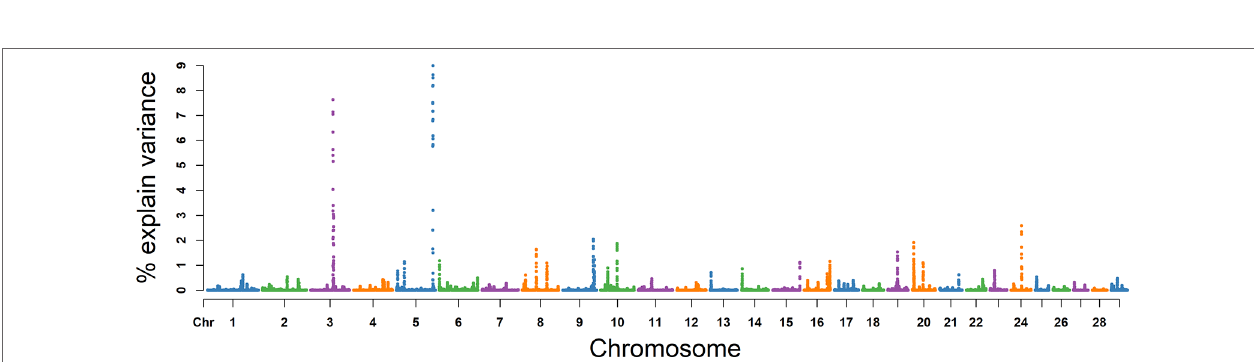
FIGURe 7 | GWAS results of number of motile sperm (NMSP) in Holstein bulls of China. Each dot represents one SNP. The X-axis represents 29 autosomes, respectively. The Y-axis represents the percentage of the explained variance by